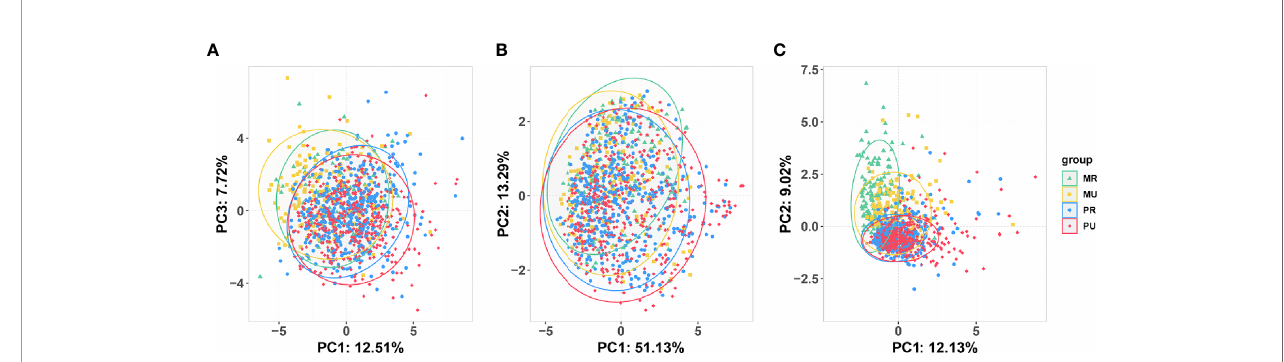
FIGURE 3 | Overview of the unconstrained (Unsupervised) ordination analysis of the participants who had undergone 16S rRNA testing for gut microbiota. (A) Principal component analysis (PCA) of clinical variables (1087 samples). (B) Principal coordinate analysis based on Bray-Curtis distance shows beta-diversity (similarity between 1177 samples) among the four groups. (C) PCA of dietary metadata (1045 samples). MR, mountain rural; MU, mountain urban; PR, plain rural; PU,